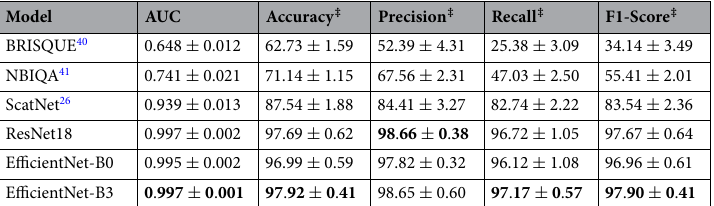
Table 1. Performance indices over 5-fold cross-validation (%). maximum accuracy Significant values are in